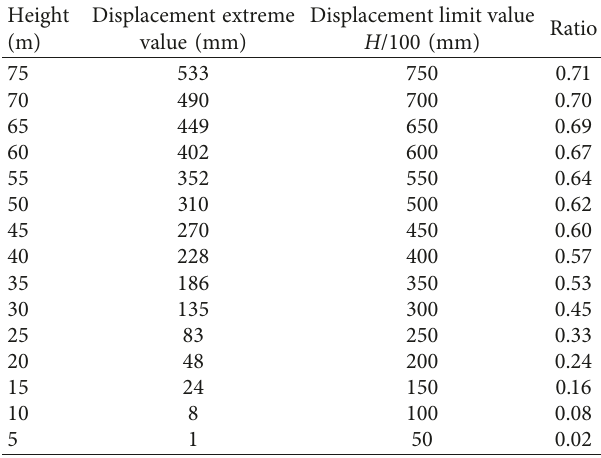
Table 5: Displacement amplitudes under wind and earthquake